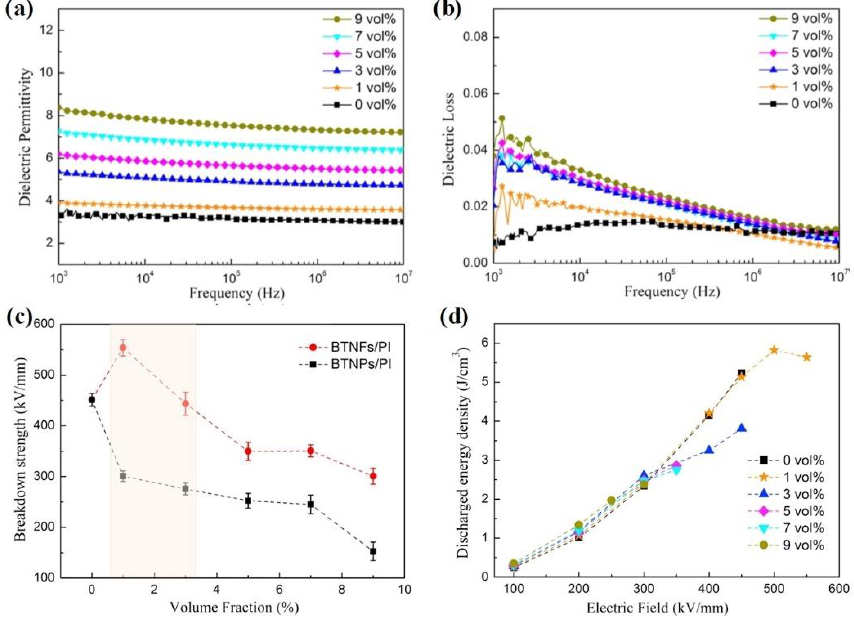
Figure 9. Frequency-dependency of dielectric permittivity ( a ) and dielectric loss ( b ) of BTNFs/PI nanocomposites. ( c ) Breakdown strength of BTNFs/PI and BTNPs/PI nanocomposites as a function of content loading. ( d ) Discharged energy density of BTNFs/PI nanocomposites as a function of the electric field. Reproduced with permission from Ref. [78]. Copyright 2018,